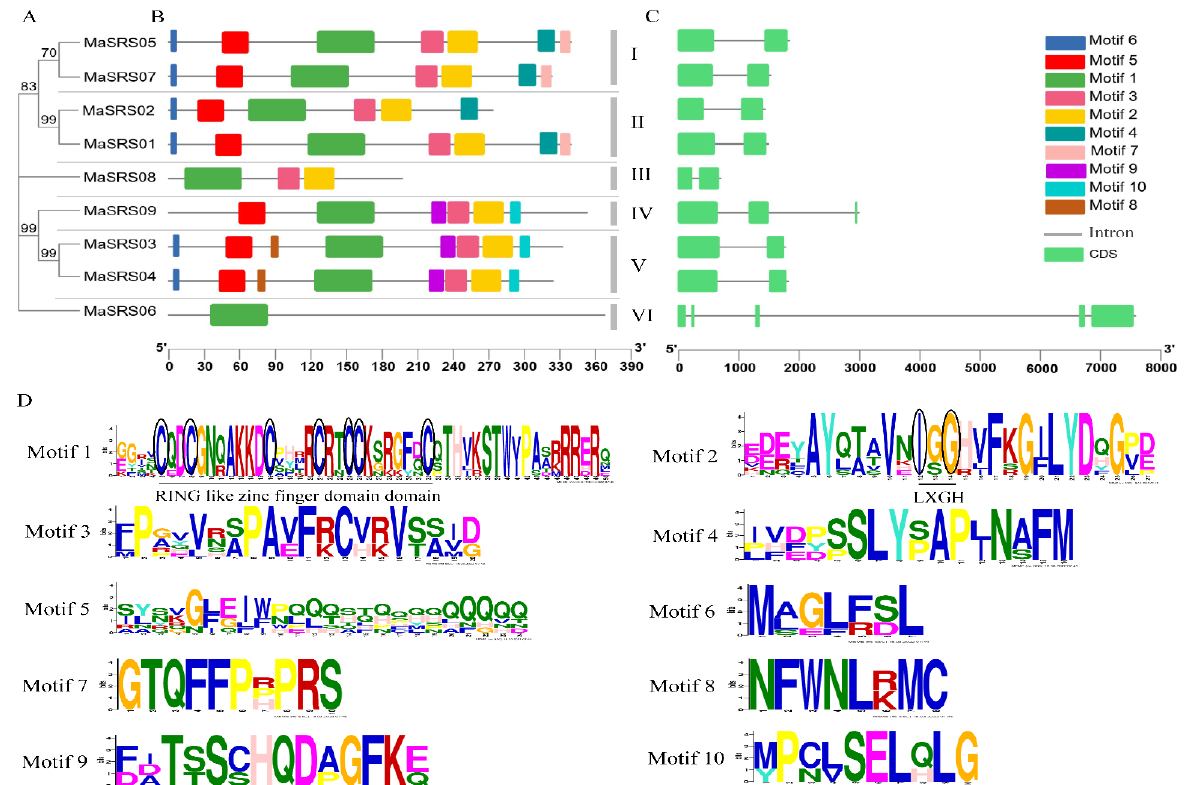
Figure 4. Gene structure and conserved protein domains of SRS genes in white sweet clover ( Melilotus albus ) showing exons, introns, and motif sequence organization. ( A ) The unrooted phylogenetic tree of the MaSRS family was constructed with 1000 bootstrap replicates, and all MaSRS members were classified into six subfamilies. ( B ) Distribution of conserved MaSRS domains. ( C ) Intron exon structure of MaSRS genes. ( D ) Ten conserved motifs in MaSRS proteins.